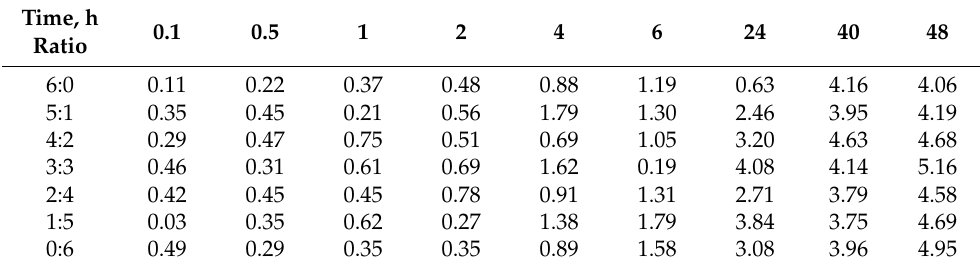
Table 1. The polymer chain binding degree at different ratios of ion exchangers ( θ ,